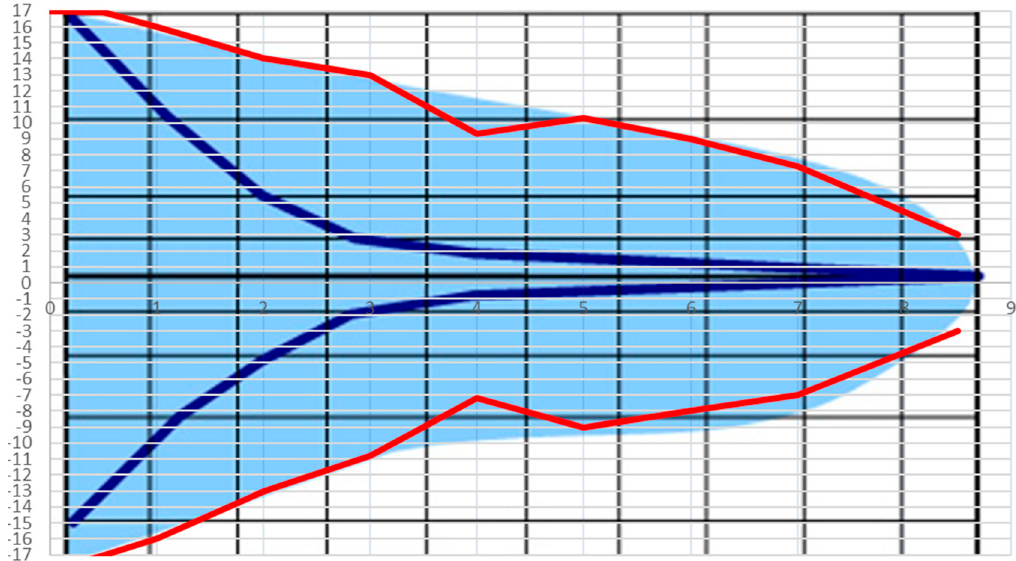
Figure 6. The variables within the pre-research analysis phase by trend line in red and in blue the trend line normalized